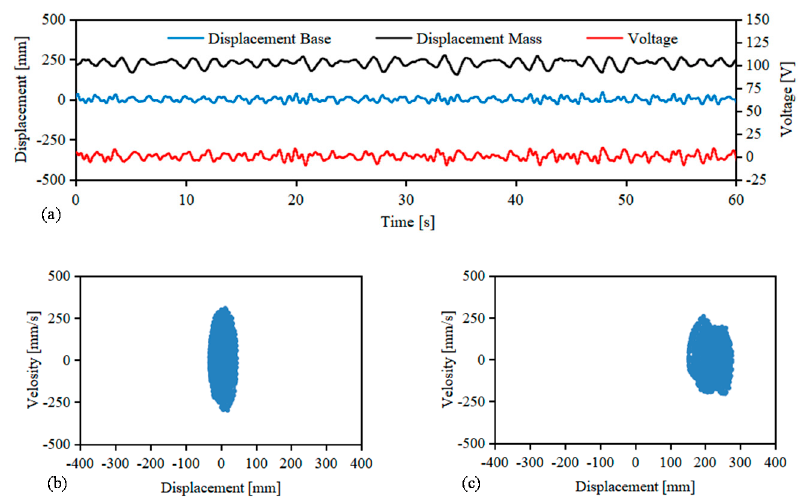
Figure 15. Measurement results of response vibration displacement and vibration power generation when vibrating with a random signal and a period signal 0.6 Hz. ( a ) Results of response vibration displacement. ( b ) Diagram of displacement velocity of vibration of the support. ( c ) Diagram of displacement velocity of vibration of the mass block.